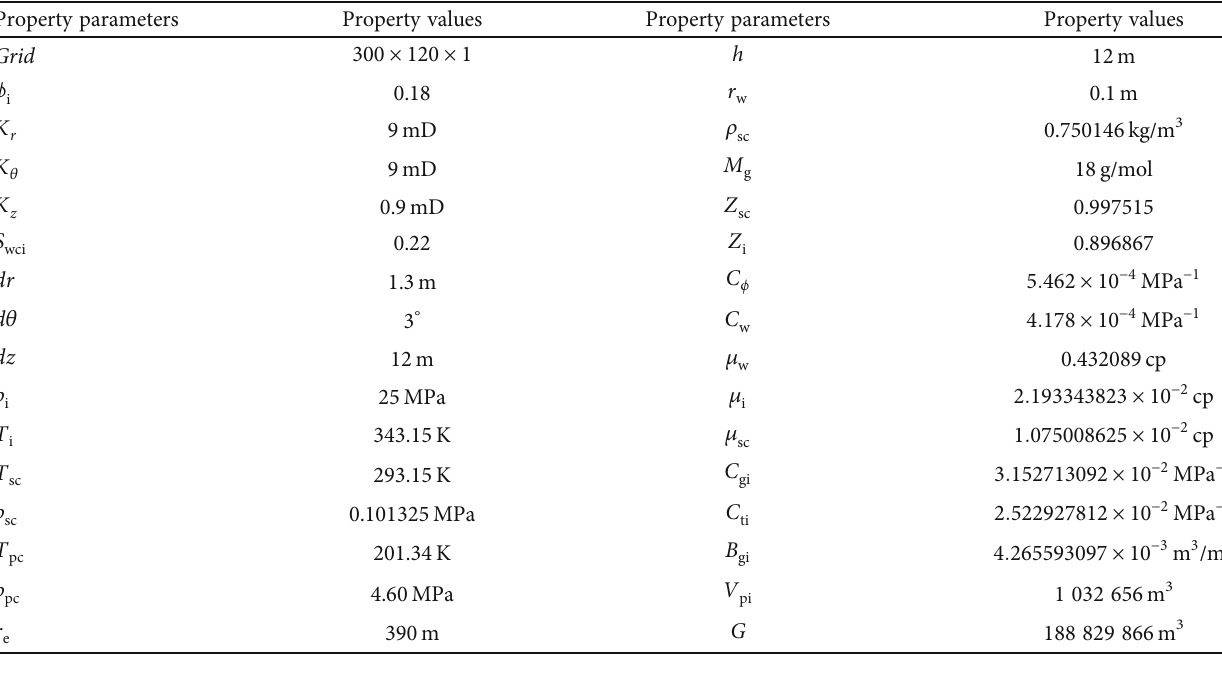
Table 1: Reservoir and gas properties for numerical cases with normal pressure.